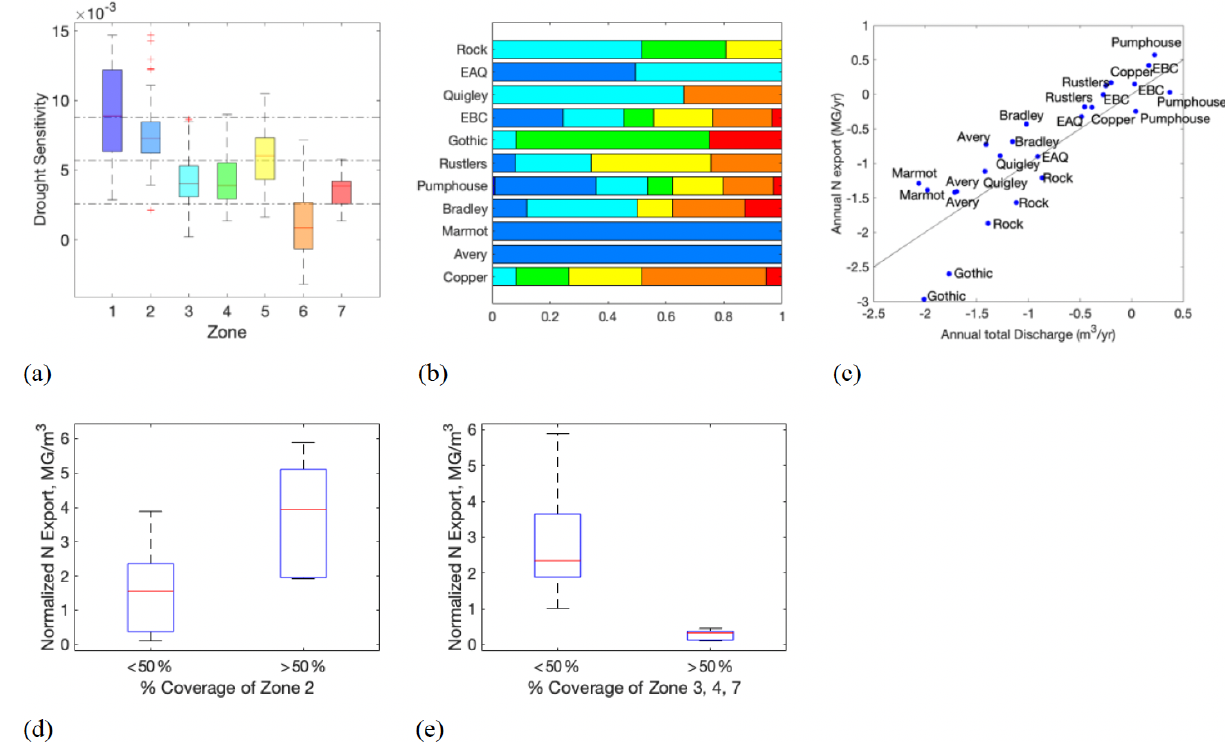
Figure 7. (a) Box plot of the foresummer drought sensitivity as a function of zones, (b) zonation coverage of each subcatchment, (c) annual discharge vs. N export in 2015, 2016, and 2017, and (d, e) normalized N export (N export divided by annual discharge) as a function of the percent coverage of (d) Zone 2 and (e) Zones 3, 4, and 7 as the conifer-dominated zone, respectively. In (b) , the color code is the same as Figs.